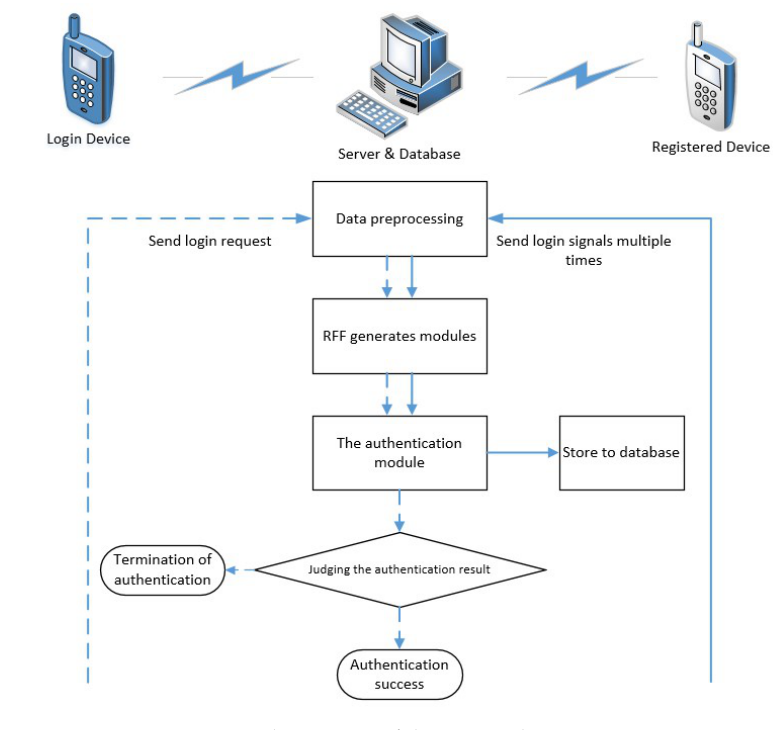
Figure 6. The process of the RFF authentication.